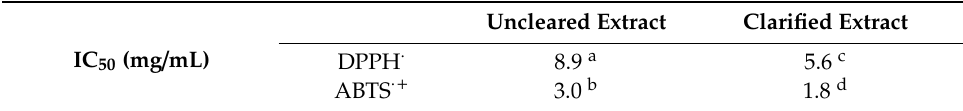
Table 2. Values necessary to inhibit 50% of the DPPH · and ABTS · + radical of the uncleared extract and clarified